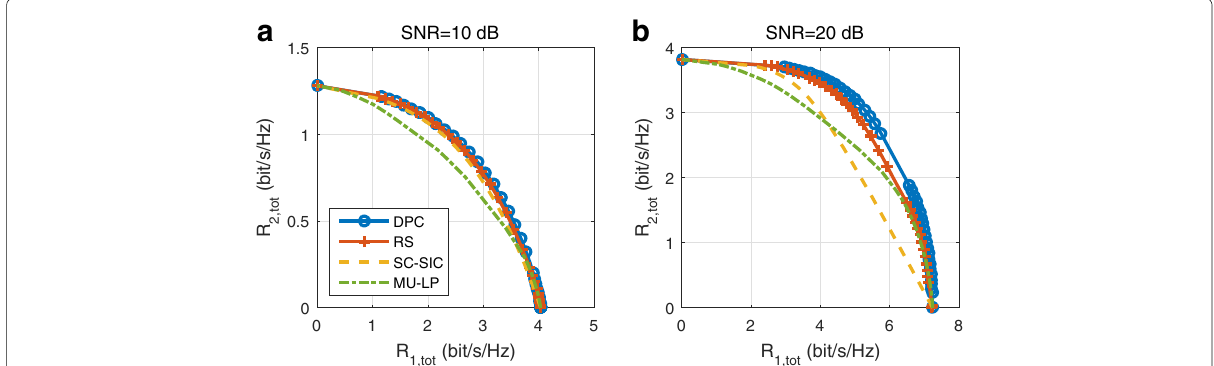
Fig. 6 Achievable rate region comparison of different strategies in underloaded two-user deployment with perfect CSIT, averaged over 100 random channel realizations, σ 2 1 = 1, σ 2 2 = 0.09, and N t = 2. a SNR = 10 dB. b SNR = 20 dB